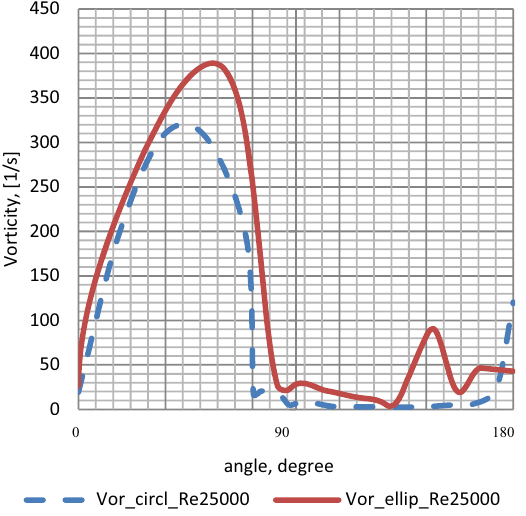
Figure 12 present the magnitude of the vorticity vector for circle and ellipse section and Re = 25 000.